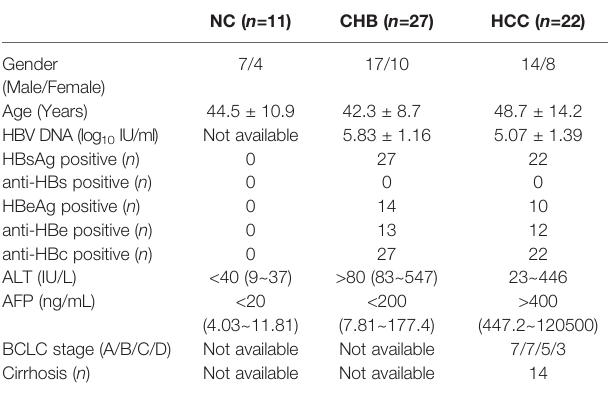
TABLE 1 | Clinical characteristics of enrolled